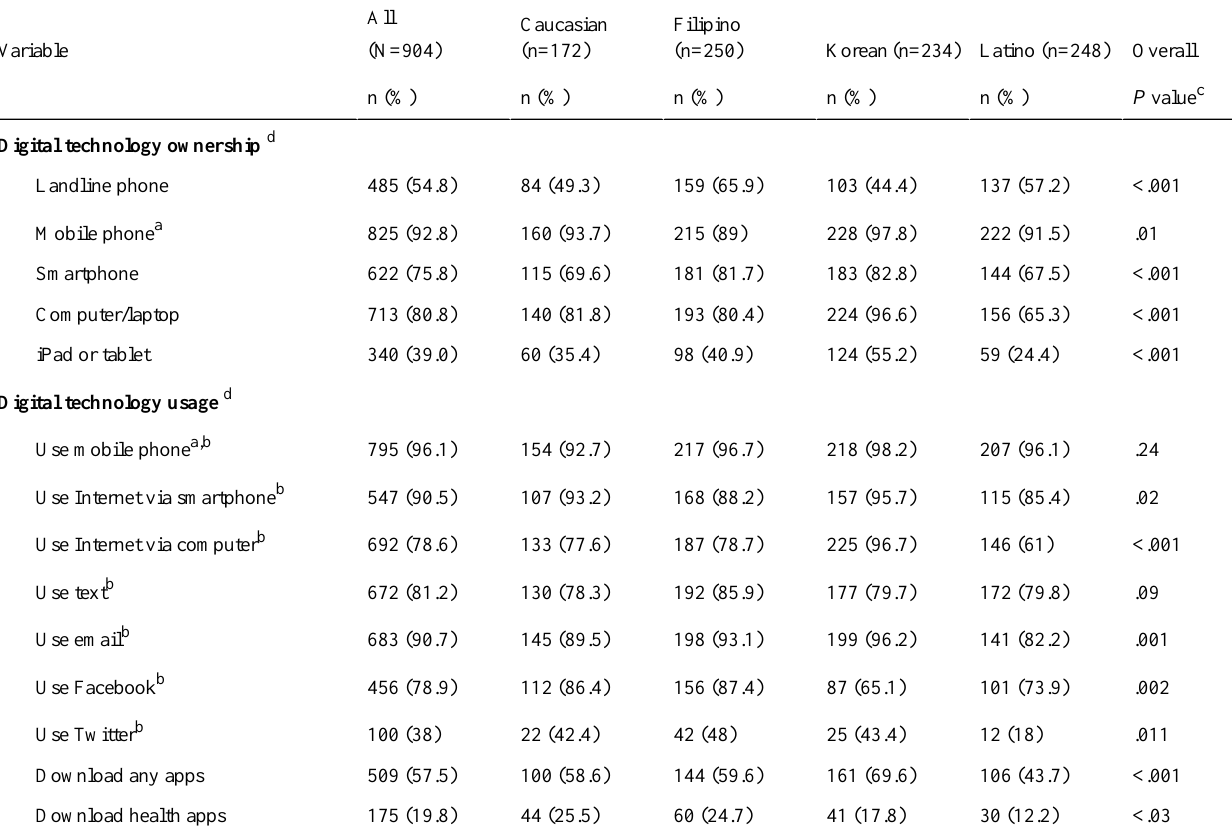
Table 2. Adjusted digital technology ownership and usage percentages by race/ethnic